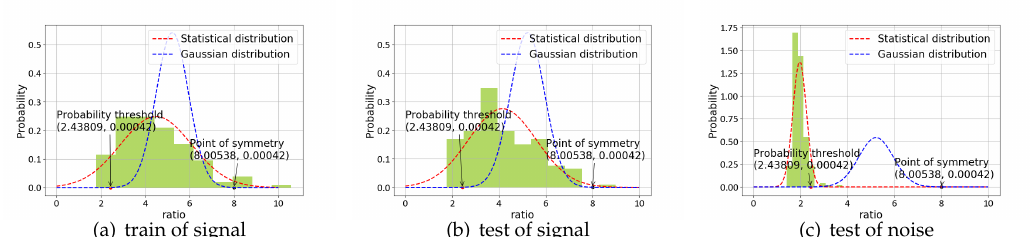
Figure 7. The probability distribution of the ratio of the STA/LTA curve. From ( a ) to ( c ), the subgraphs are the train set data distribution, the seismic test set distribution, and the noise test set distribution of the ratio feature. The red dotted line represents the statistical distribution, while the blue dotted line is the distribution obtained by the Gaussian process using prior information.